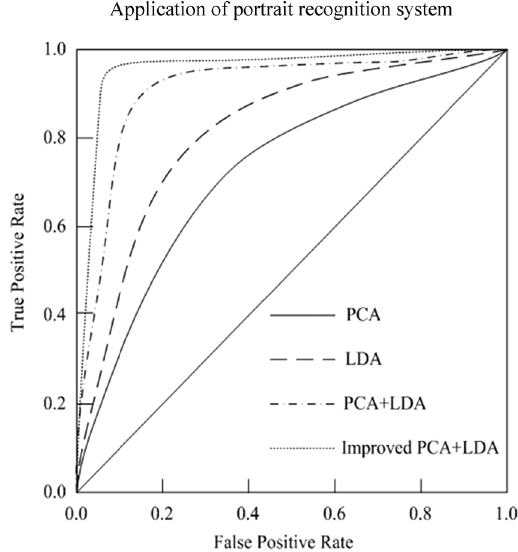
Figure 3: The ROC curve of di ff erent algorithms.